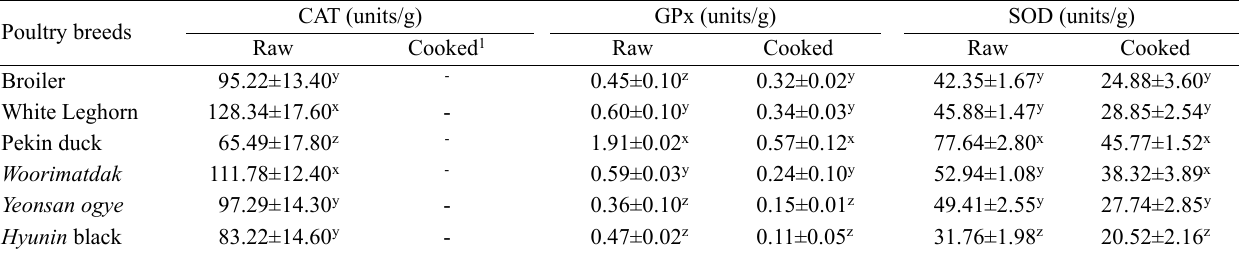
Table 2. Antioxidant enzyme activity of raw and cooked thigh meat from different breeds of poultry Poultry breeds